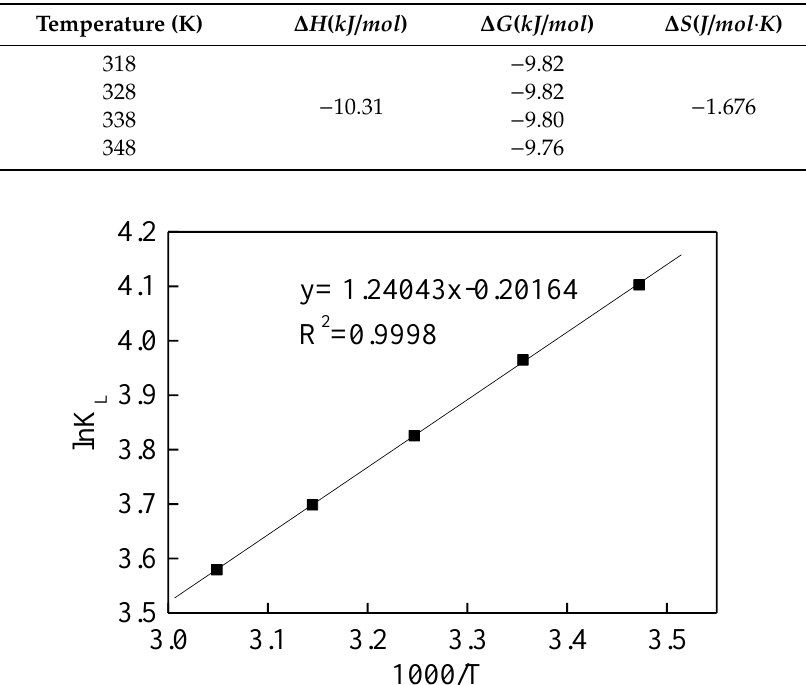
Table 5. Adsorption Thermodynamic Parameters at Di ff erent Temperatures.